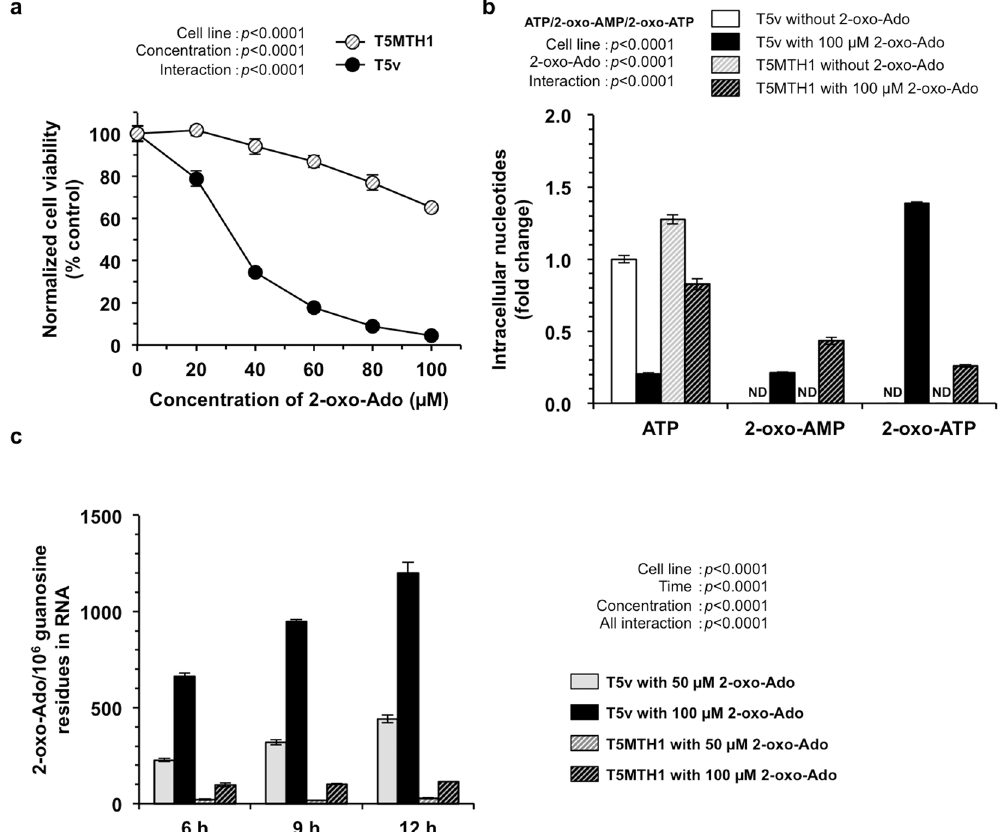
Figure 3. Human MTH1 prevents 2-oxo-Ado-induced cell death. ( a ) Cell viability of mouse MTH1-null MEFs (T5v cells) and mouse MTH1-null/human MTH1-expressing MEFs (T5MTH1 cells) was determined by WST-8 assays after incubation for 24 h in the presence of various concentrations of 2-oxo-Ado. Values (% control) of cell viability relative to that in the absence of 2-oxo-Ado for each cell line are shown as the mean ± SD of three experiments. Results were statistically analysed by two-way ANOVA. ( b ) Intracellular nucleotide concentrations of T5v and T5MTH1 cells were determined by HPLC after incubation for 6 h in the presence or absence of 100 µ M 2-oxo-Ado. Values (fold change) of indicated nucleotides relative to ATP in T5v cells in the absence of 2-oxo-Ado are shown as the mean ± SD of three experiments. The concentration of ATP in T5v cells in the absence of 2-oxo-Ado was 11.6 nmol/1 × 10 6 cells and that in T5MTH1 cells was 14.9 nmol/1 × 10 6 cells. Results were statistically analysed by two-way ANOVA for ATP, 2-oxo-AMP, 2-oxo-ATP, separately. ( c ) 2-Oxo-Ado residues relative to 1 × 10 6 guanosine residues in RNA of T5v and T5MTH1 cells was determined by LC-MS/ MS. RNAs were collected after incubation with the indicated concentrations of 2-oxo-Ado for various times. Results are shown as the mean ± SD of three experiments. Results were statistically analysed by three-way